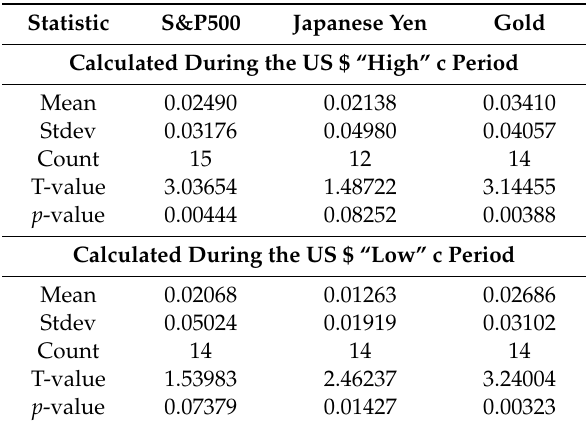
Table A1. h c − h T (HRs based on US